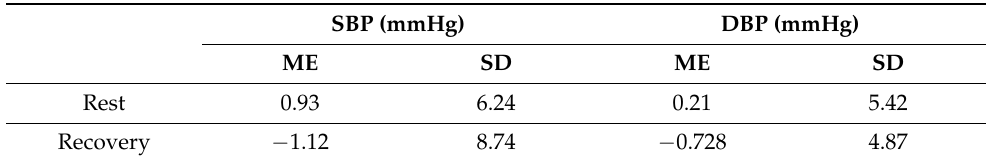
Table 1. Mean errors (ME) and standard deviations (SD) of systolic and diastolic blood pressures (SBP and DBP) in the rest and recovery